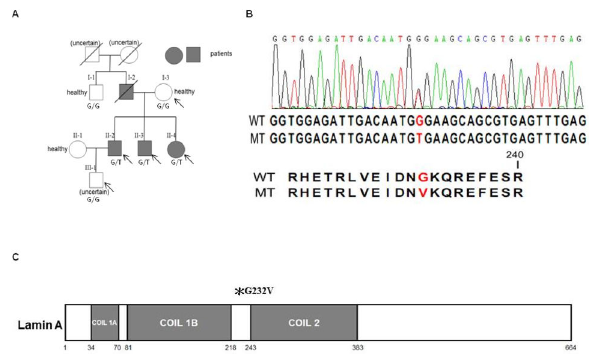
Figure 1. Novel LMNA mutation (G232V) segregates with inherited cardiac conduction disease. ( A ) Pedigree of the studied family. The pedigree shows the affection statuses, individual identifiers, and genotypes at LMNA c.G695T. The samples (marked by arrows) I-3, II-2, II-3, II-4 and III-1 were exome sequenced. The I-1, I-3 and II-1 samples were from healthy individuals, and the phenotype of sample III-1 was uncertain. ( B ) Sequencing result showing the heterozygous LMNA c.G695T (G232V) mutation. WT, wild type allele; MT, mutant allele. ( C ) Schematic of Lamin A protein. *G232V mutation in the 1B−2 linker region. doi: